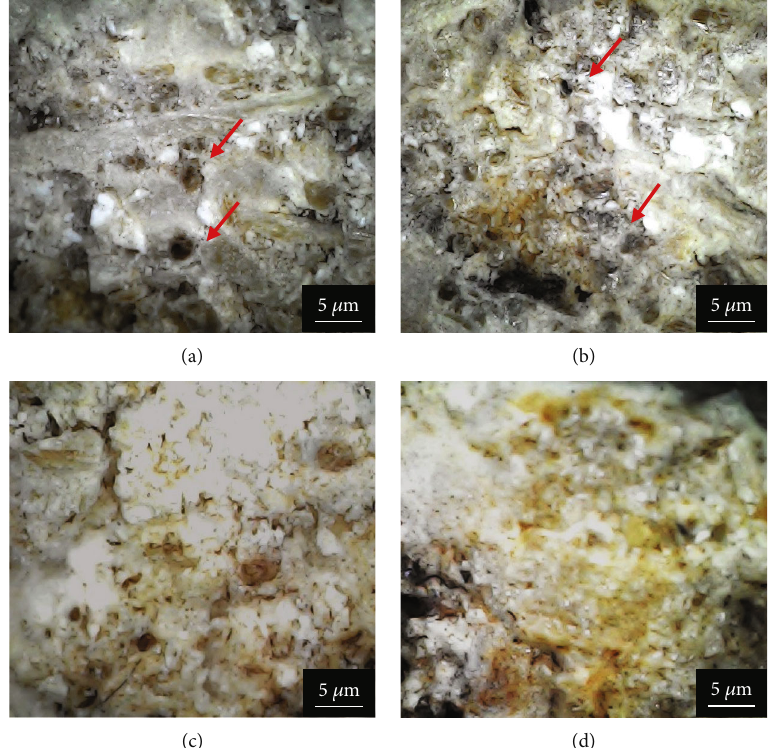
Figure 7: Morphology of cross section of biofoam cup with 1600x magnitude: DB-SF1 (a), DB-SF1.5 (b), B-SF1 (c), and B-SF1.5 (d).